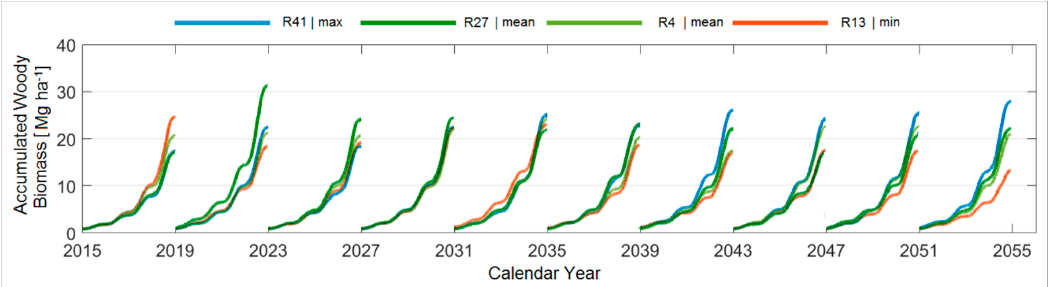
Figure 3. Projected accumulated woody biomass of poplar trees under realisations that rendered minimum (R13, orange), mean (R4, light green; R27, dark green), and maximum (R41, blue) average precipitation sum values during the vegetation period from 2015 to the end of 2054.